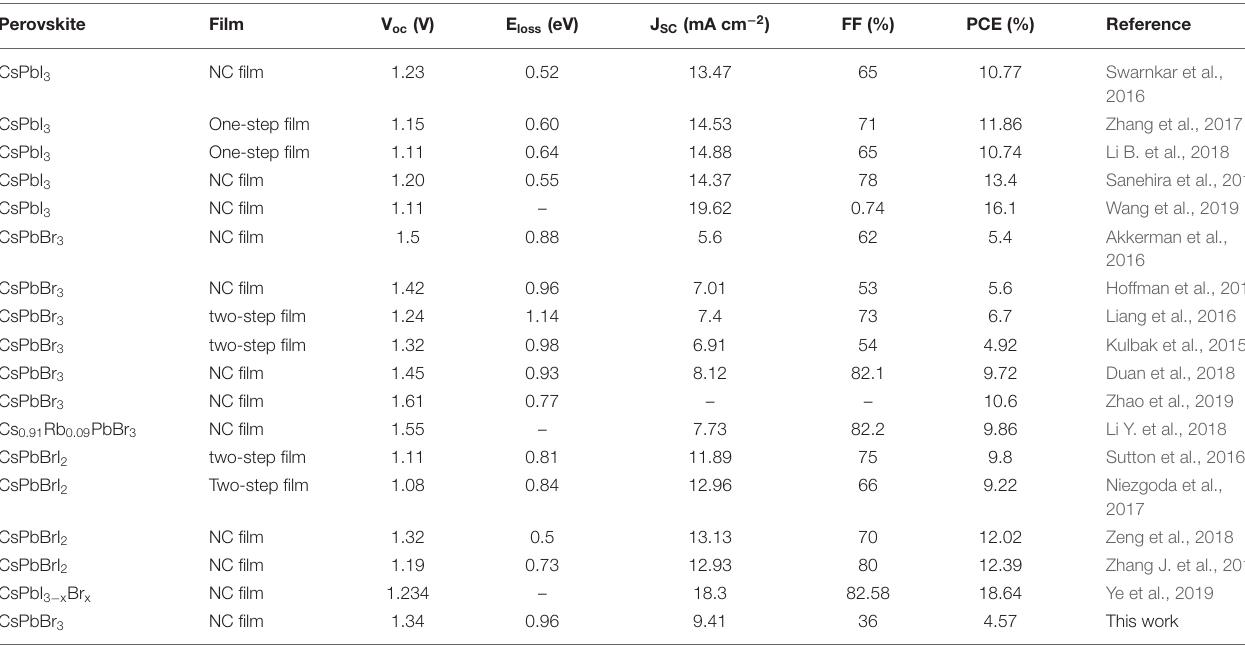
TABLE 1 | Photovoltaic parameters for the all-inorganic perovskite solar cells.